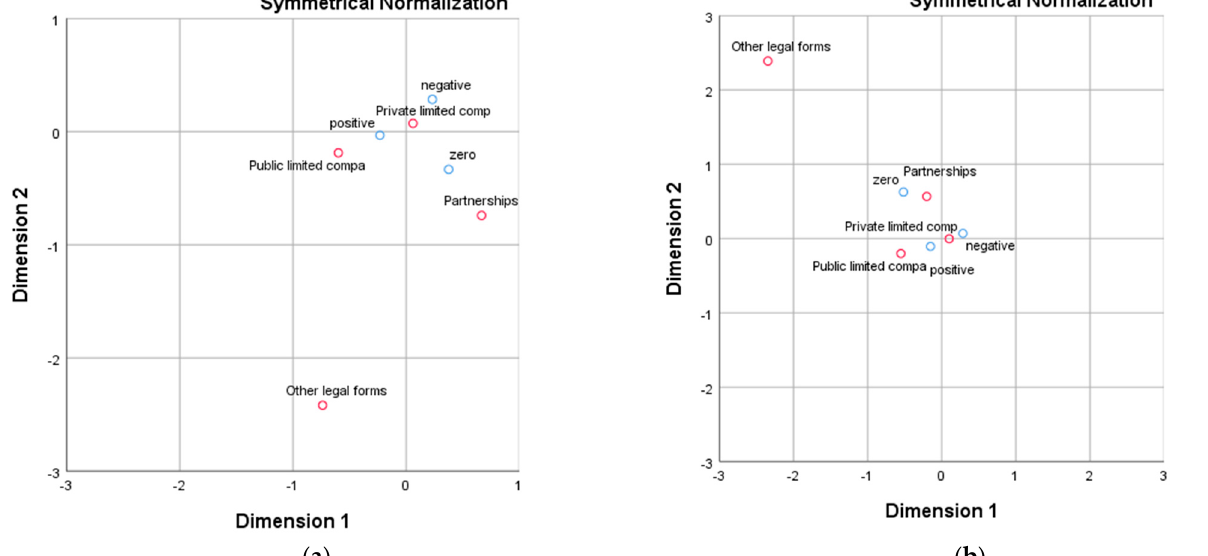
Figure 3. Correspondence map: ( a ) 2017/2018; ( b ) 2018/2019.